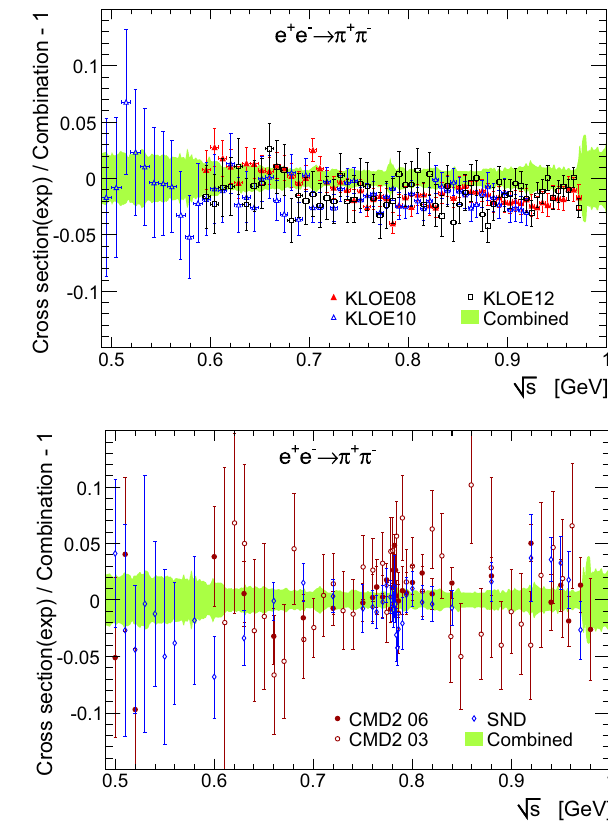
Fig. 2 Comparison between individual e + e − → π + π − cross- section measurements from BABAR [4,5], KLOE08 [6], KLOE10 [7], KLOE12 [13], BESIII[14], CMD203 [8], CMD206 [9–11], SND[12],